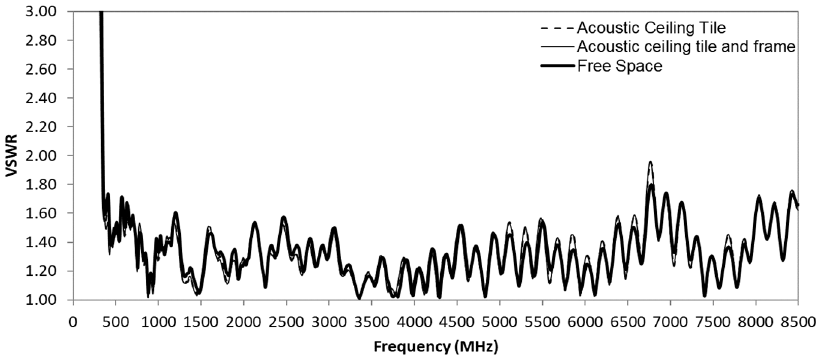
Figure 31. Ceiling tiles and frame effect to the antenna measured VSWR.